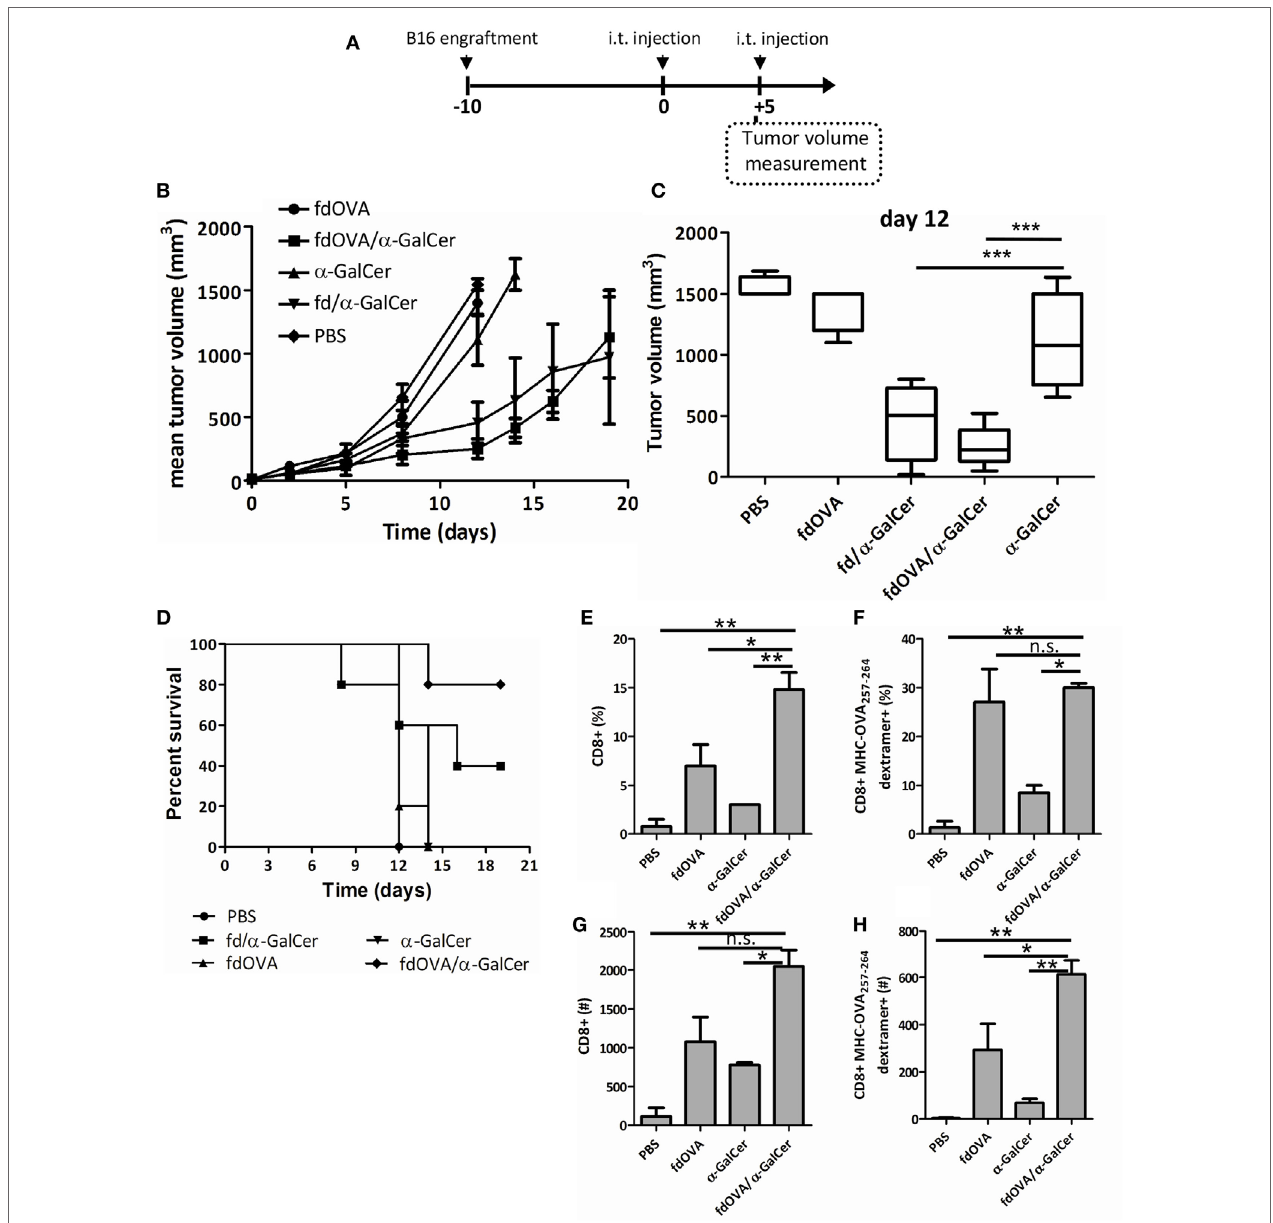
FigUre 6 | Filamentous bacteriophage fd co-delivering tumor antigen and alpha-GalactosylCeramide ( α -GalCer) induces a stronger anti-tumor response. Mice ( n = 5/group) were challenged with B16-OVA expressing melanoma cells. When tumor was palpable (day 0) mice were immunized intratumorally with fd/ α -GalCer, fdOVA/ α -GalCer, fdOVA, free α -GalCer, or with phosphate buffered saline. The injection was repeated at day 5, and tumor volume was monitored with a caliper over time. (a) Schematic representation of the experiment. (B) Tumor growth recorded during experiment. The chart shows the mean tumor size reached in each group. Line for each group ends once more than half of the group is culled. (c) Box plot of tumor volumes recorded at day 12 post vaccination. Median values are represented by the horizontal line. p < 0.001 by one-way analysis of variance (ANOVA) followed by a Dunnett’s multiple comparison test. *** p < 0.001 (D) Kaplan–Meier survival curves of B16-engrafted mice during the experiment. p < 0.05 between fdOVA/ α -GalCer and free α -GalCer-treated mice group by log-rank (Mantel–Cox) test. (e-h) Groups of mice treated as above were sacrificed at day 12 post vaccination and tumor infiltrating lymphocytes were evaluated. Mean percentages (e,F) and absolute numbers (g,h) of CD8 + T cells gated on 7-AAD negative cells (e,g) and of H2Kb-SIINFEKL dextramer positive gated on CD8 + T cells (F,h) are reported. p < 0.01 by one-way ANOVA followed by a Dunnett’s multiple comparison test. * p < 0.05, ** p < 0.01. Abbreviation: ns, not significant.